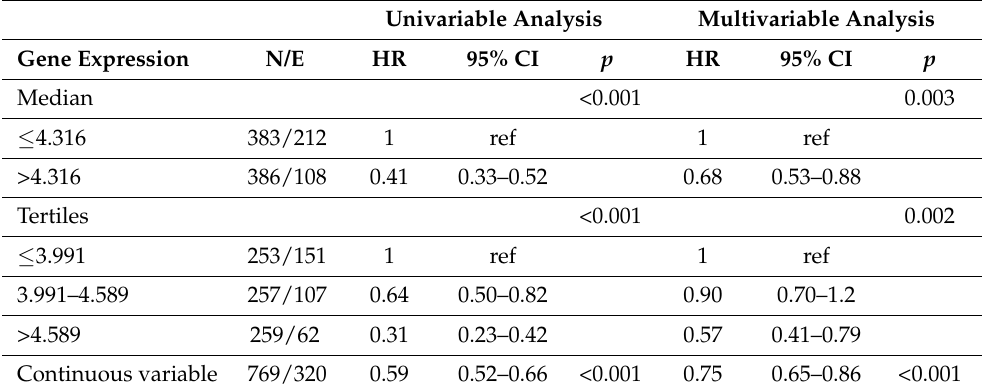
Table 5. Event Free Survival of 769 NB patients in relation to MYT1L expression levels evaluated by the Cox model.